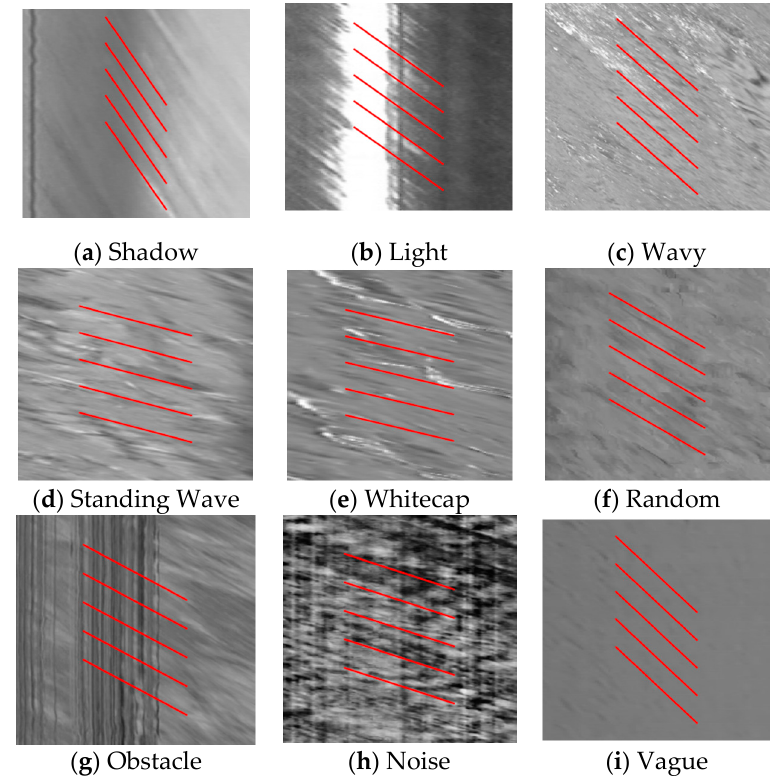
Figure 8. Categorized STIs (red lines are CNN estimated angles).